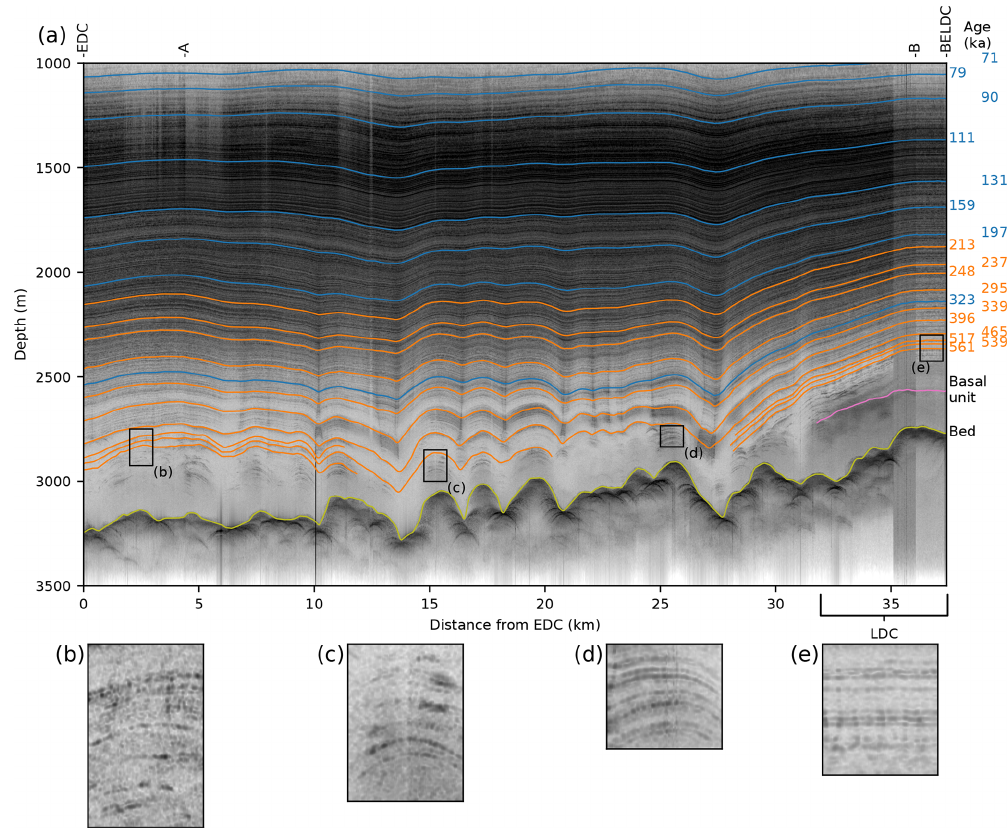
Figure 2. (a) Radargram extending from EDC to the chosen ice-core site, BELDC. Blue and orange lines show horizons traced by Winter et al. (2017) and newly traced here, respectively, with ages on the right. Marks at the top show turns in the profile, as noted on Fig. 1. (b–e) Zoom-ins of discontinuous horizons at locations in panel (a)